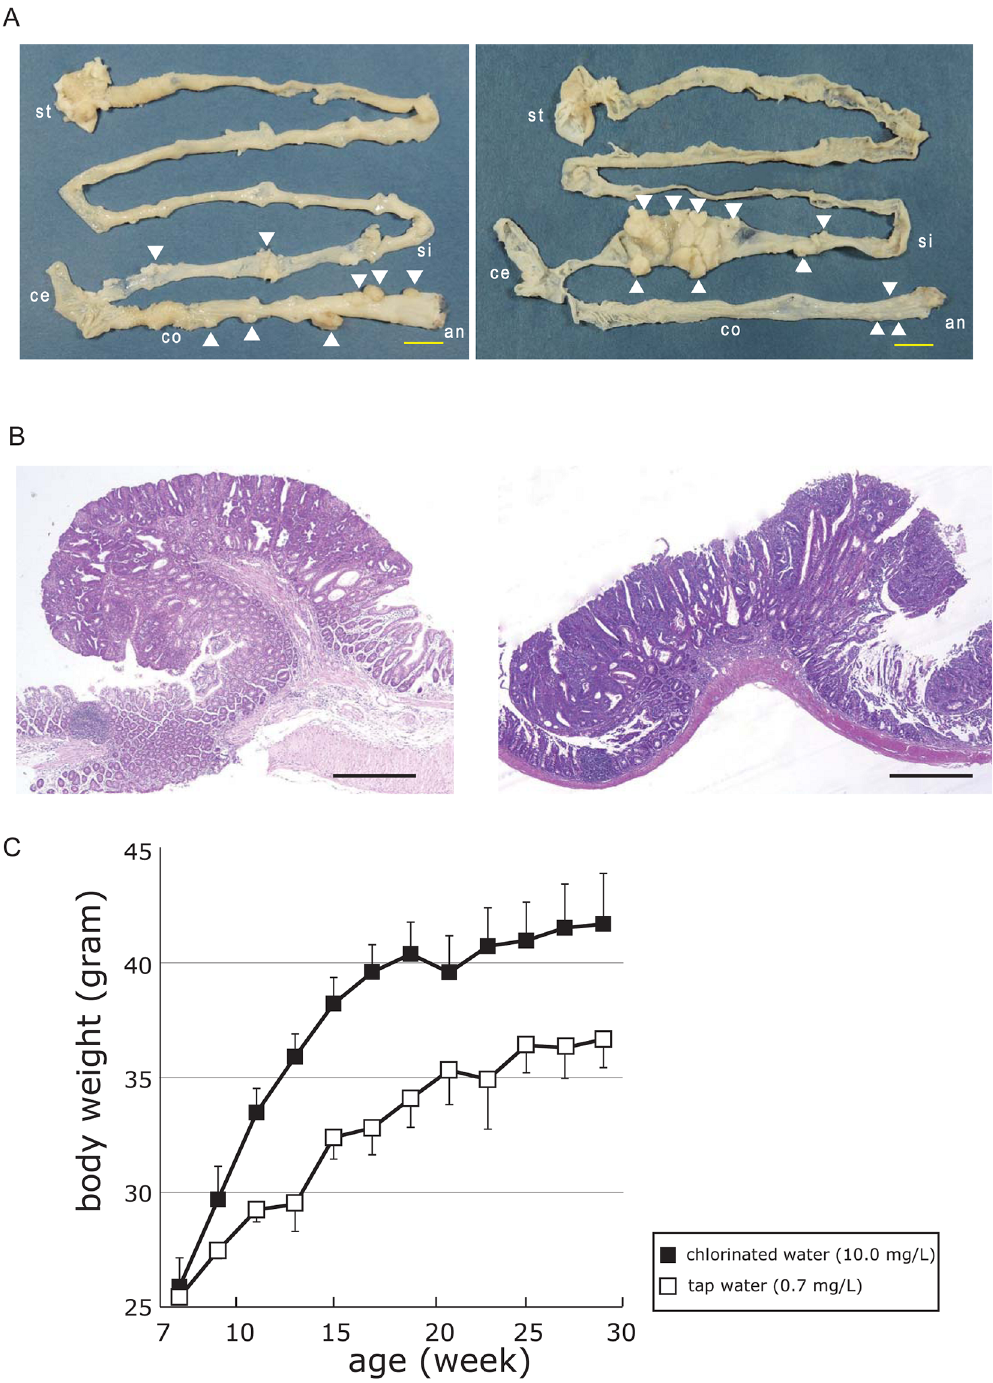
Fig 1. Tumorigenesis and body weight in CPC;Apc mice. A, Tumorigenesis in 40-week-old CPC;Apc mice. Left, mouse administered chlorinated water (10.0 mg/L chlorine). Right, mouse administered tap water (0.7 mg/L chlorine). Tumors were mainly detected in the colon and at the end of the ileum in the chlorinated and tap water groups, respectively. st, stomach; je, jejunum; ce, cecum; co, colon; an, anus. Bar, 10 mm. B, Tumor histology in CPC;Apc mice. H&E staining of a colonic tumor from a chlorinated water-treated mouse (left) and a small intestinal tumor from a tap water-treated mouse (right). Bar, 500 μ m. C, Body weight gain in the chlorinated water group (black box) was the same as in wild-type C57B/6 mice, while the tap water group (white box) had significantly lower weight gain. * P < 0.05 (ANOVA).